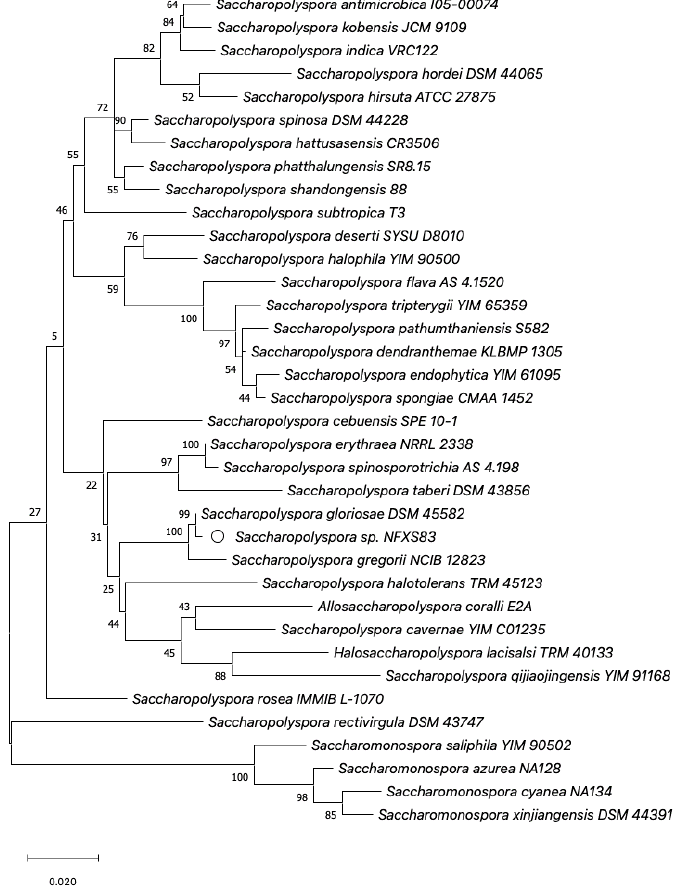
Figure 1. Phylogram based on the 16S rRNA gene of Saccharopolyspora type strains and other related type strains.